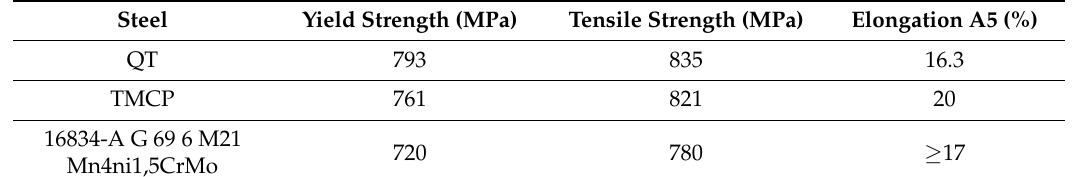
Table 2. Mechanical properties of the steels and welding wire.